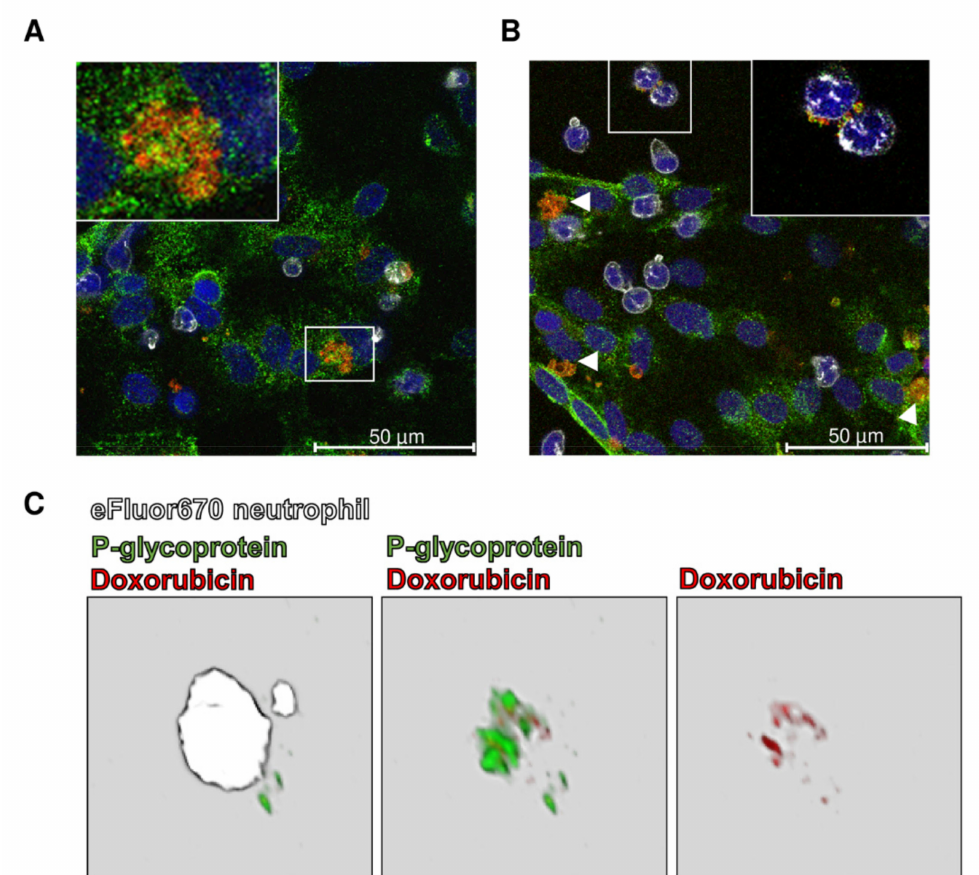
Figure 6. Barrier-body formation and ingestion by porcine neutrophils after treatment of primary porcine brain capillary endothelial cells (pBCECs) with doxorubicin. ( A ) pBCECs were isolated from porcine brain and treated with doxorubicin (10 µ M, 37 ◦ C, 30 min; depicted in red) 5 days after culturing. Freshly isolated porcine neutrophils were labeled with the fluorescent dye eFluor670 (depicted in white) and incubated with the pBCEC culture for 10 min, 37 ◦ C. Cells were fixed with aceton-methanol, indirectly stained for P-glycoprotein (Pgp, depicted in green), and analyzed by confocal fluorescence microscopy. Nuclei were counterstained with 4 (cid:48) ,6-diamidino-2-phenylindole (DAPI; depicted in blue). Doxorubicin localizes in Pgp-positive perinuclear vesicular structures (inset in ( A )) identified as endolysosomal vesicles (see Ref. 140). The white frame outlines the section magnified (inset). ( B ) The doxorubicin-containing vesicles were released by the pBCECs and form aggregates (barrier bodies; arrowheads) at the apical surface of the cells. The inset in (B) highlights the ingestion of barrier bodies by neutrophils. ( C ) 3D reconstruction of an eFluor670 stained neutrophil that ingested a barrier body after incubation with doxorubicin-treated pBCECs. The 3D reconstruction was performed with Leica Application Suite (LASX, version 1.9.0.13747). The first micrograph in ( C ) shows a merge of the three channels eFluor670 (white), Pgp (green), and doxorubicin (red). The barrier body, ingested by the neutrophil (white), consists of a Pgp-containing membrane that encloses doxorubicin, which becomes visible when the eFluor670 channel is masked out (micrographs 2 and 3 in ( C )). Unpublished figure from B.